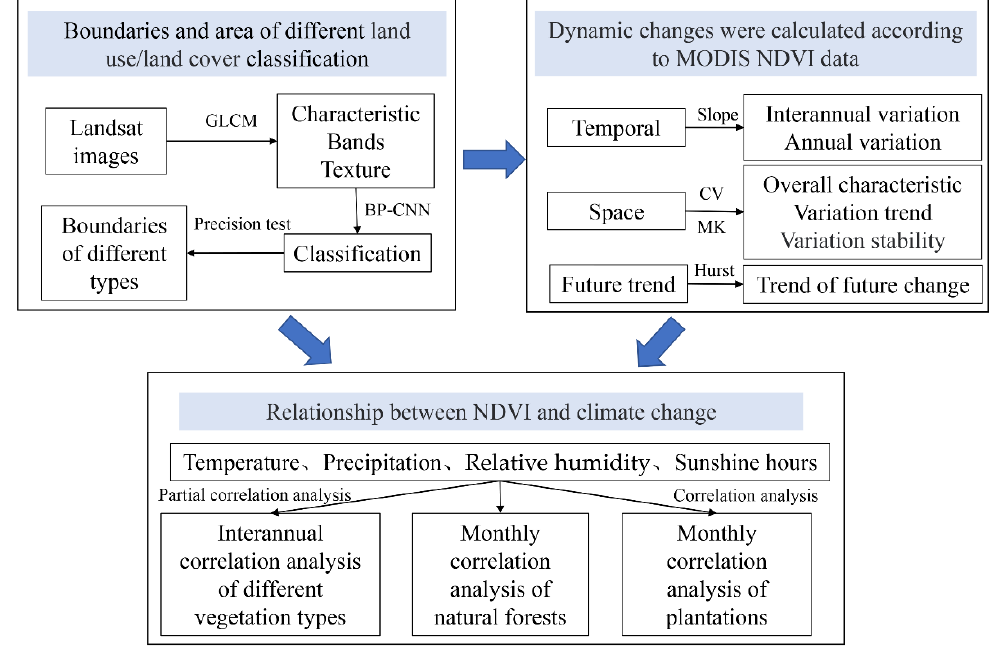
Figure 2. Flow chart of the main steps of dynamic changes of plantations and natural forests in study area and their relationship with climatic factors.